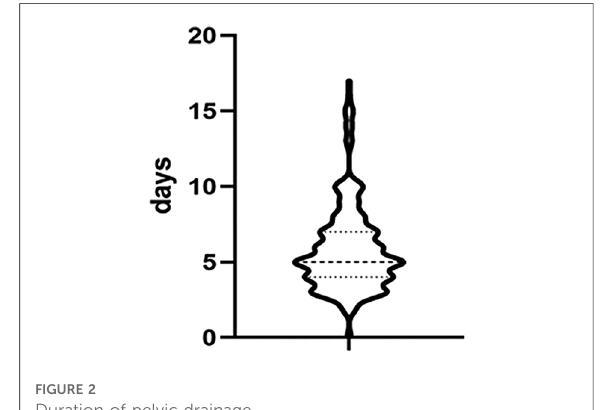
FIGURE 2 Duration of pelvic